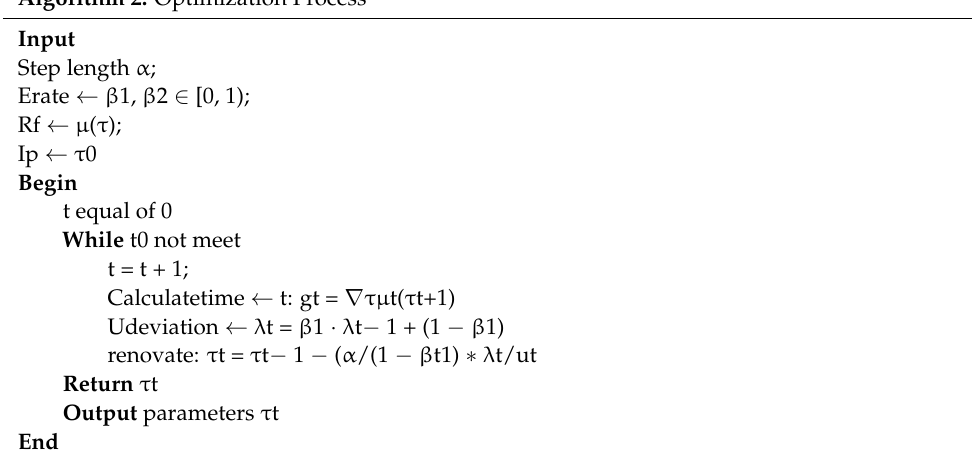
Algorithm 2: Optimization Process